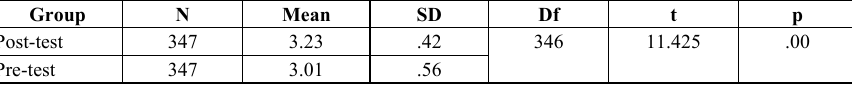
Table 1. Paired Sample t-test for the data of teaching engineering ethics Group N Mean SD Df p Post-test 347 Pre-test 347 3.01